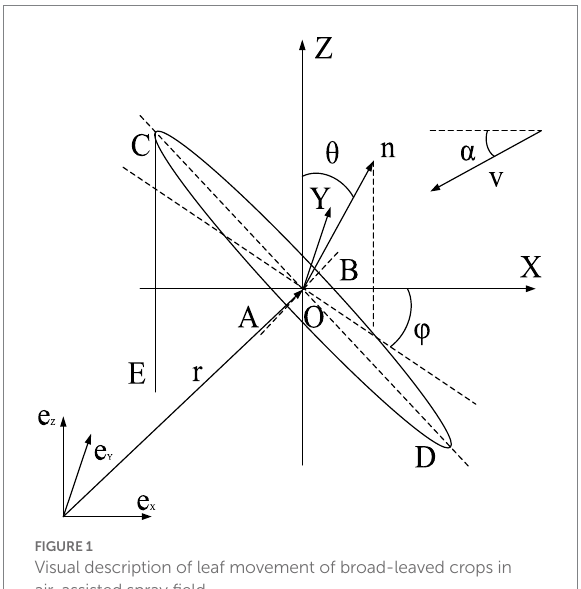
FIGURE 1 Visual description of leaf movement of broad-leaved crops in air-assisted spray